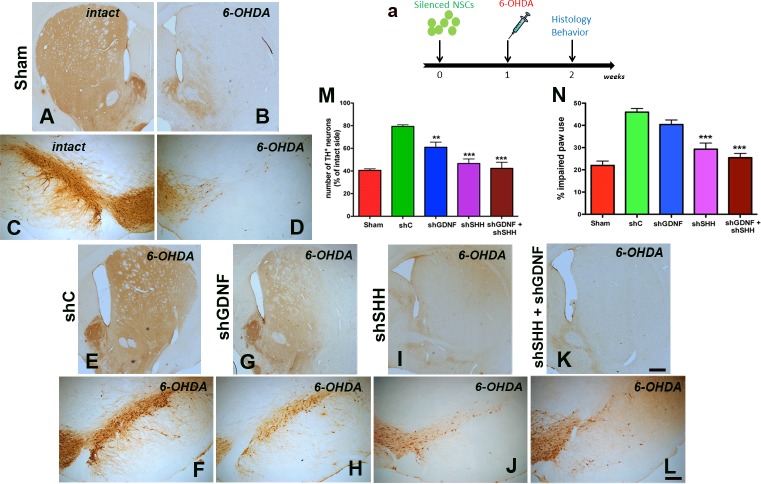
SHH silencing inhibits the neuroprotective effects of donor NPCs.NPCs carrying shRNA’s directed at GDNF, SHH or both were implanted into the striatum and SN of Fisher 344 rats 1 week before the administration of 6-OHDA (a). Behavioral assessment using spontaneous paw placement in the cylinder task (N), at two weeks after NPC implantation indicated that animals which had received NPCs with non targeted control shRNA (shC) displayed preservation of the function of the affected forepaw (contralateral to 6-OHDA lesion) compared to animals receiving no cells (just medium). However, rats receiving SHH silenced grafts (shSHH or both shSHH+shGDNF) showed a significant reduction in the ability to use the affected forepaw, similar to sham rats. GDNF silencing did not have any effect on the therapeutic benefit of NPC grafts in the forepaw task (N). Immunohistological staining showed that the preservation of TH immunoreactivity in the striatum (E) and SN (F) observed in the control NPC transplanted group was visibly reduced in the animals with shSHH and shSHH+shGDNF silenced grafts (I, J, K, L). Animals that had received shGDNF NPC grafts showed partial preservation of TH immunoreactivity in the striatum (G) and SN (H) compared to shSHH (I, J) and shSHH+shGDNF (K, L) grafted animals. Stereological estimates of TH+ cells in the SN also showed a similar pattern with the shSHH and shGDNF+shSHH showing greatest potential to reduce the neuroprotective effect of the control NPCs. Values are expressed as mean ± SEM [**p<0.01, ***p<0.001 compared to sham controls, two way RM-ANOVA with Tukey’s post-hoc test for behavioral data in N, one way ANOVA with Bonferroni’s post-hoc test for stereological estimates in M]. Scale bar: 500 μm